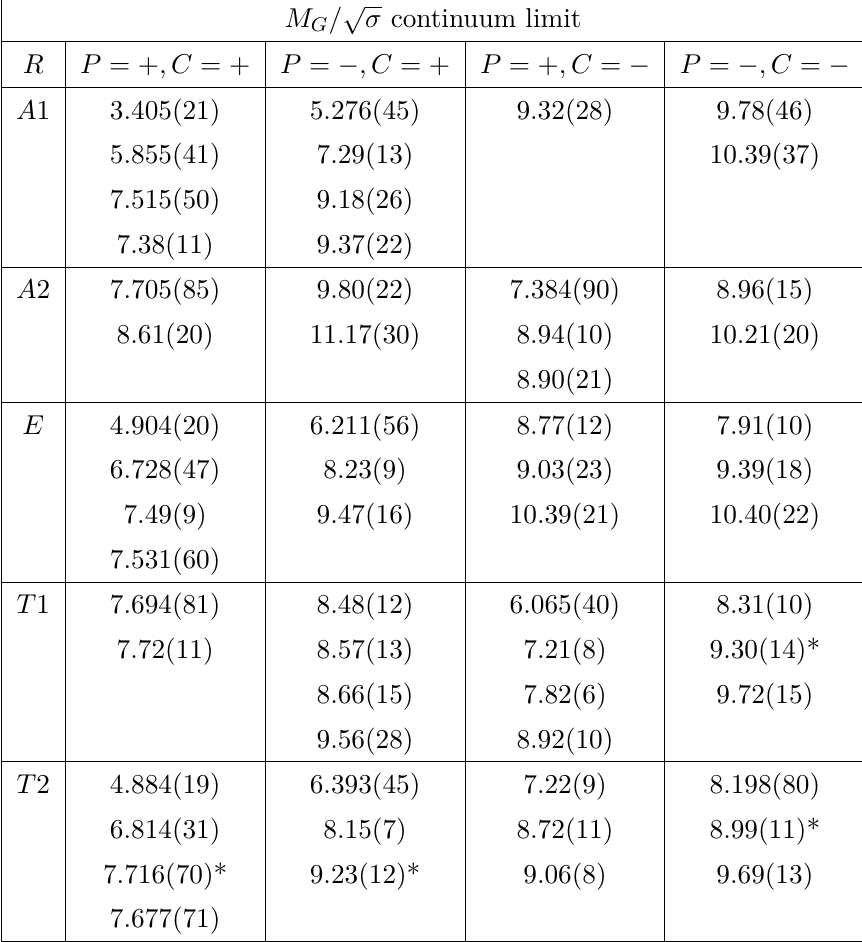
Table 14 . Continuum limit of glueball masses in units of the string tension, for all representations, R , of the rotation symmetry of a cube, for both values of parity, P , and charge conjugation, C . Ground states and some ecited states. Stars indicate poor fits ( χ 2 per degree of freedom greater than